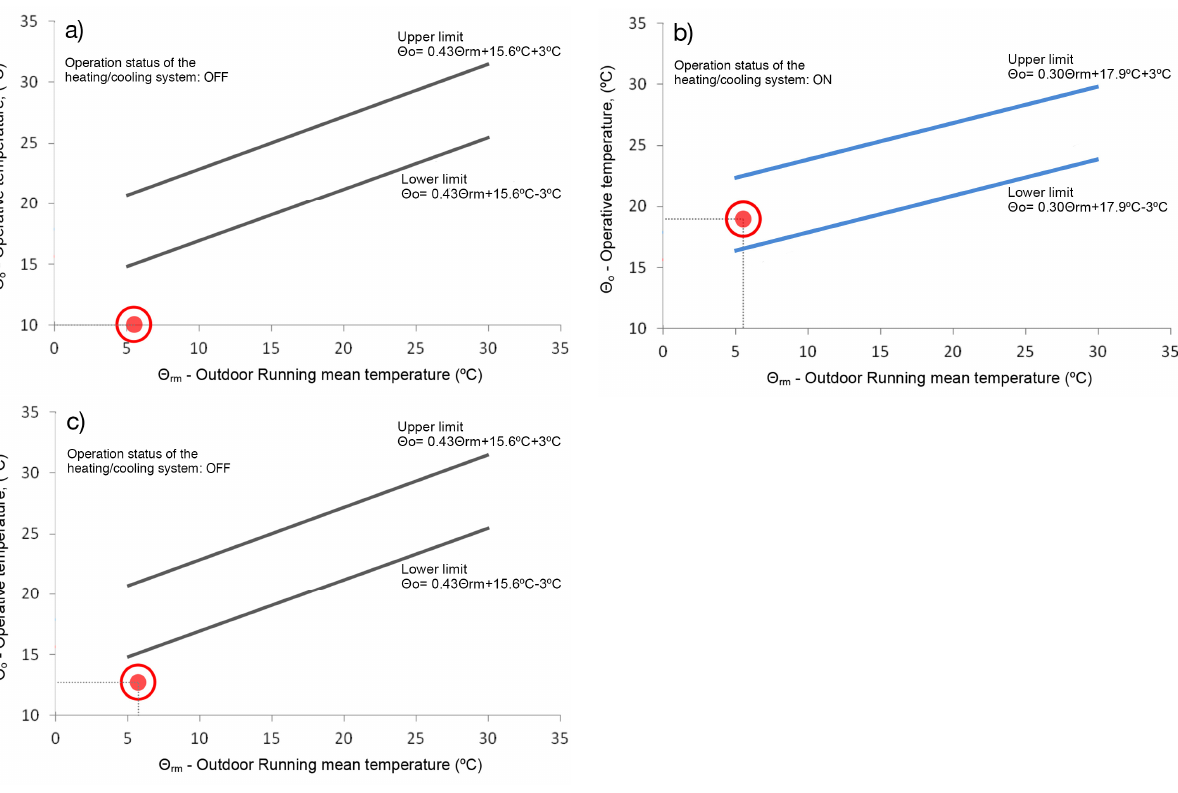
Figure 11. ( a ) Thermal comfort temperature (operative temperature) in the kitchen and living room during winter monitoring without heating system; ( b ) Thermal comfort temperature (operative temperature) in the kitchen and living room during winter monitoring with the heating system on; ( c ) Thermal comfort temperature (operative temperature) in the bedroom/balcony during winter monitoring without heating system. Based on the relation between the limits of the indoor operative temperature ( Θ o ) as a function of the exponentially-weighted running mean of the outdoor temperature ( Θ rm ) (adapted from